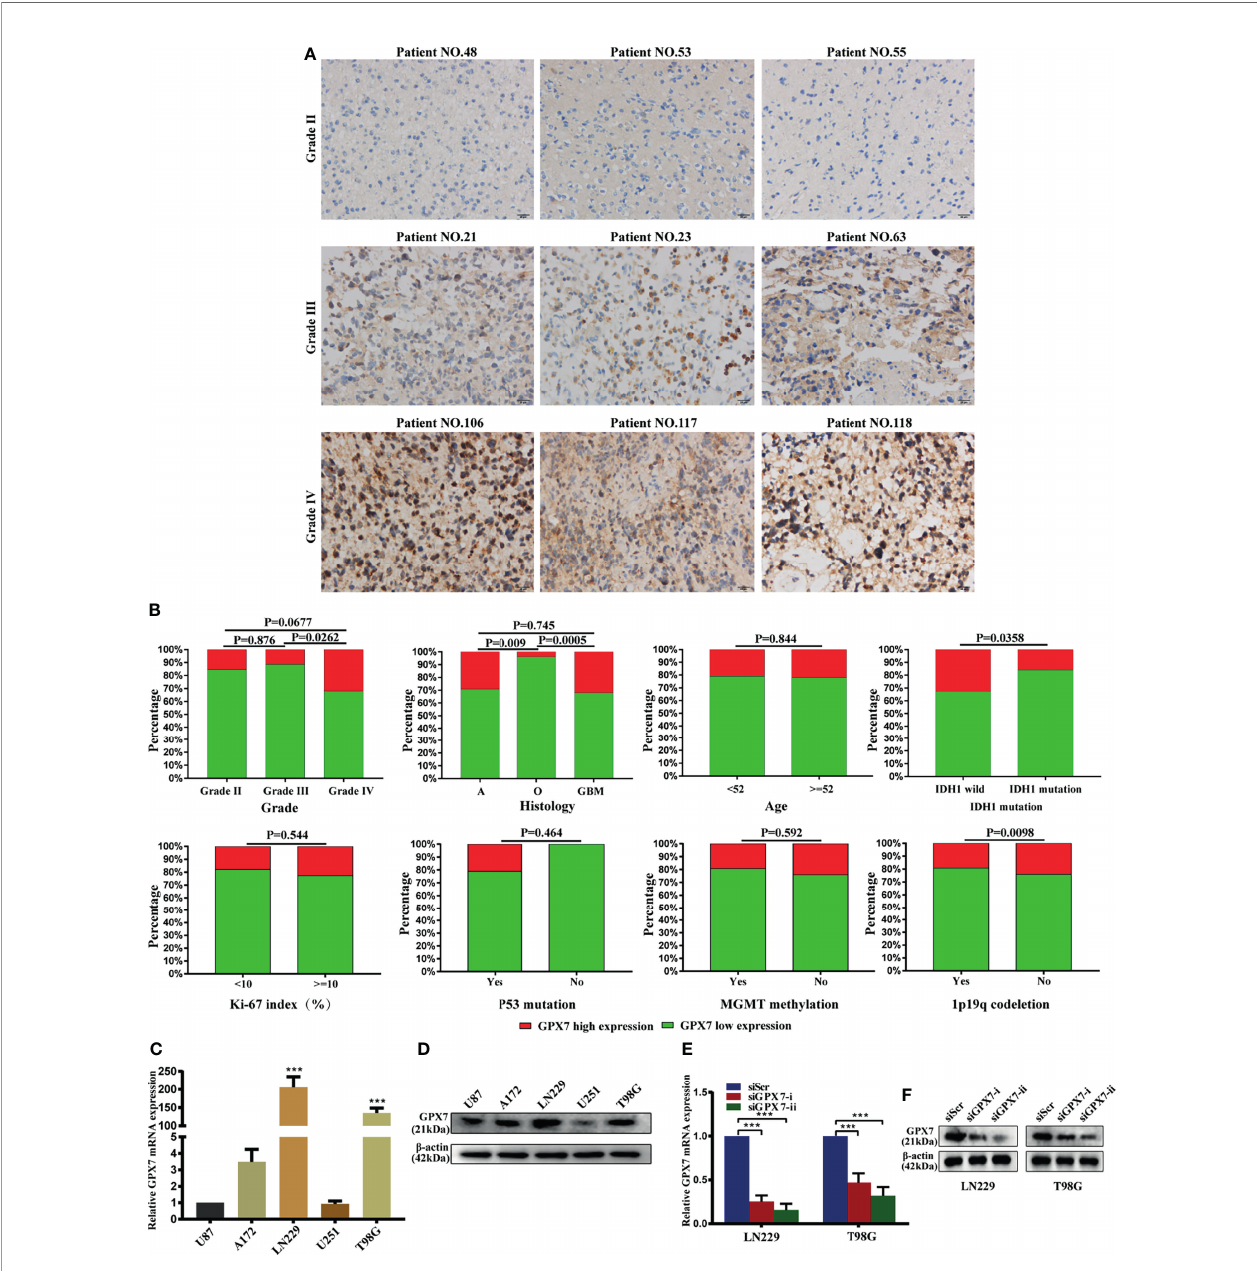
FIGURE 3 | The protein expression of GPX7 in Huanhu cohort. (A) Representative IHC slides of specimens with grade II, III and IV. Patients ’ numbers were recorded in Table S2 . (B) Associations between GPX7 protein level and clinical variables in the Huanhu cohort. (C, D) The mRNA and protein levels of GPX7 in fi ve different GBM cell lines using qPCR (with U87 as a control) and western blot. (E, F) PCR and western blot were performed to determine the expression of GPX7 after transfection with two siRNAs (siGPX7-i and siGPX7-ii). ***P <